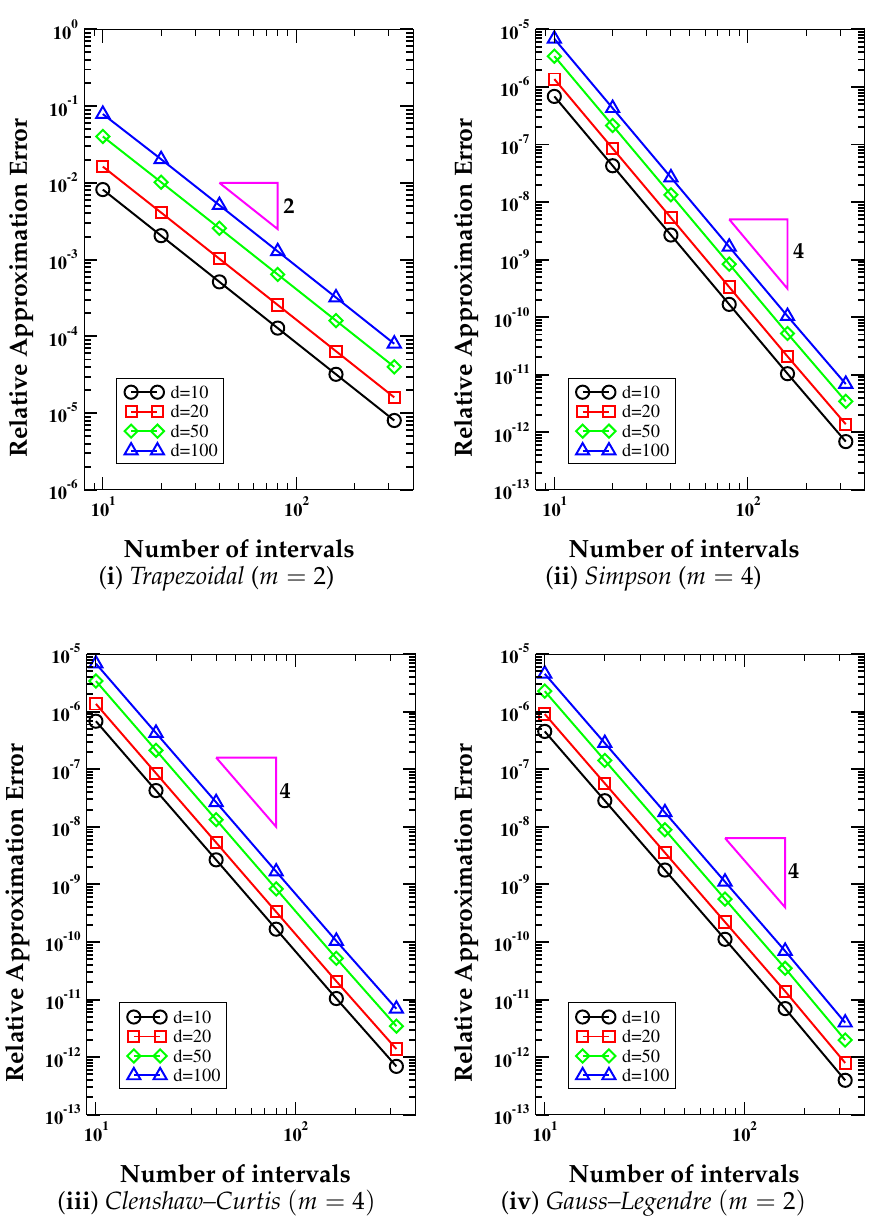
Figure 3. Test Case 2. Relative approximation error curves versus the number of intervals N per direction for the numerical integration of a d -dimensional Gaussian bell-shaped function (Genz-4), d = 10,20,50,100, using the ( i ) trapezoidal formula ( m = 2); ( ii ) Simpson formula ( m = 4); ( iii ) Clenshaw–Curtis formula ( m = 4); ( iv ) Gauss–Legendre formulas ( m = 2 ) . The expected convergence rate is shown by the number close to the triangular shapes and is proportional to N − 2 (trapezoidal rule) and N − 4 (Simpson, Clenshaw–Curtis, and Gauss–Legendre